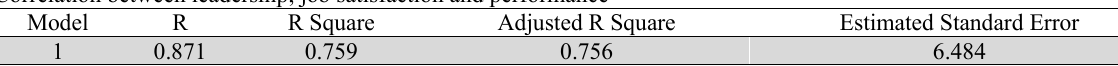
Correlation between leadership, job satisfaction and performance